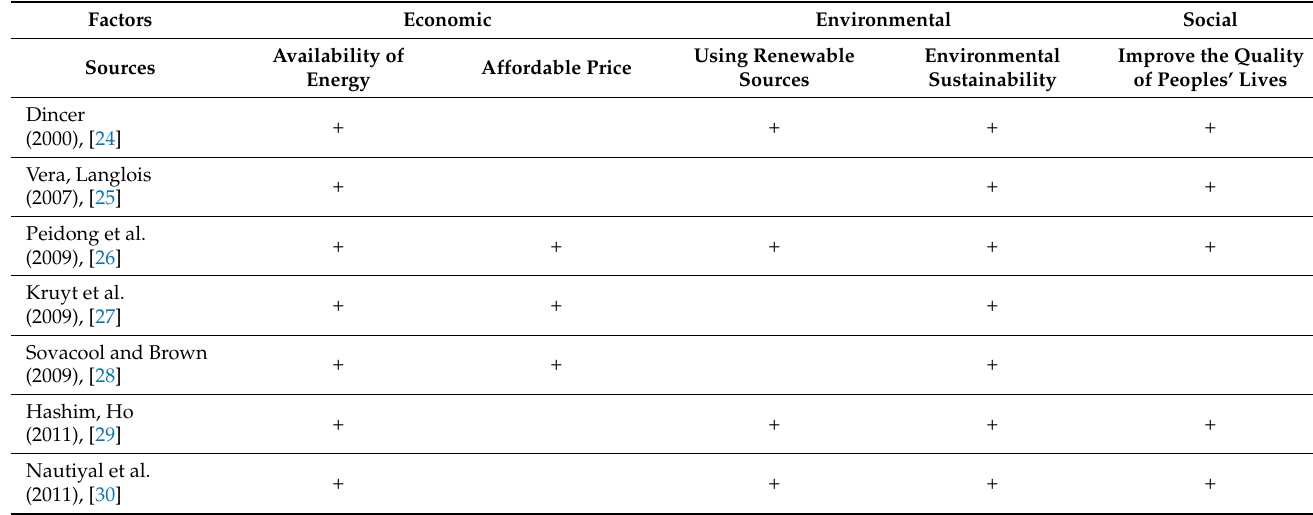
Table 1. Factors most often indicated in the definitions of sustainable energy.